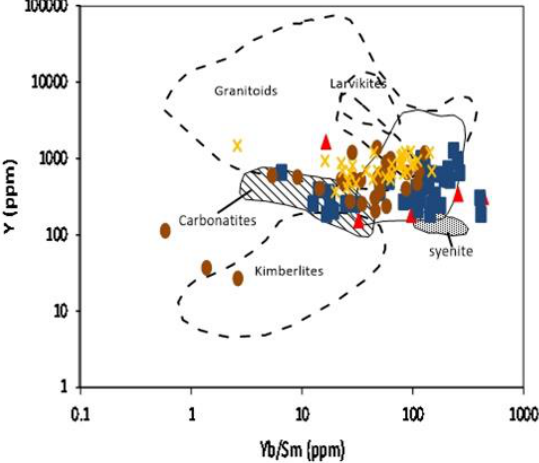
Figure 11. Y versus Yb/Sm plot for southern Meiganga detrital zircons (the lithounit fields are from [4,71]). Red triangles represent zircon with Th/U < 0.2; blue squares represent zircon with Th/U ratios [0.2 to 0.5]; brown circles represent zircons with Th/U ratios [>0.5 to 1.0]; and stars represent zircons with Th/U > 1.0).